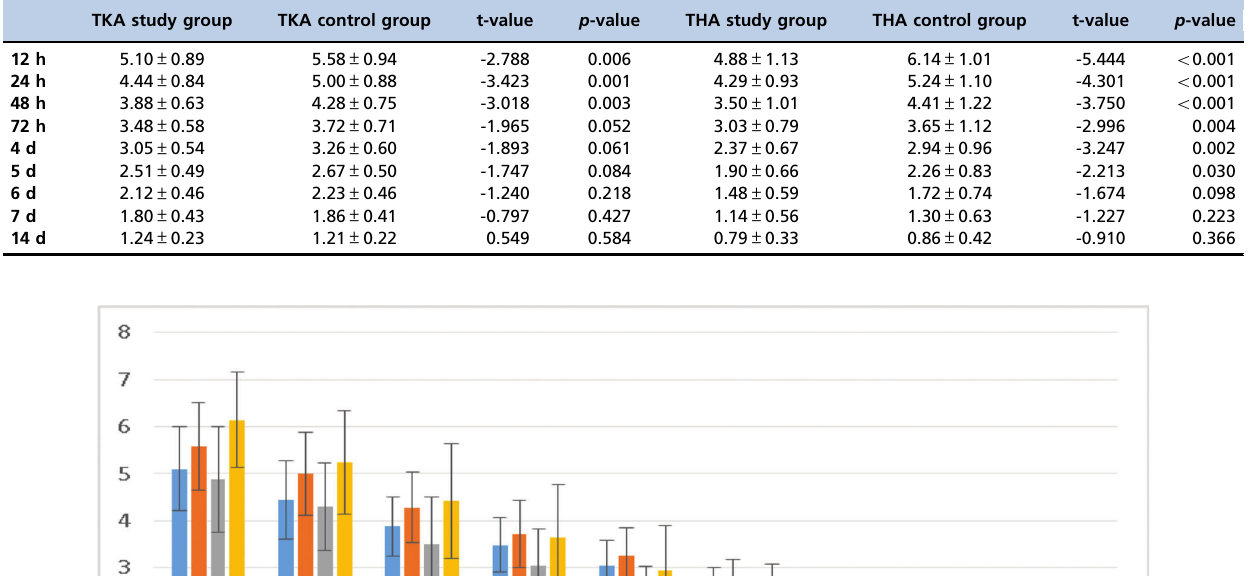
Table 3 - The NRS scores at rest.